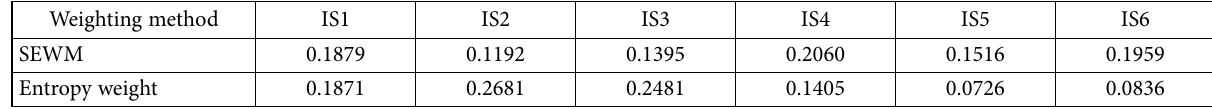
Table 5. Comparison of classification results between DCM and K-means Classification